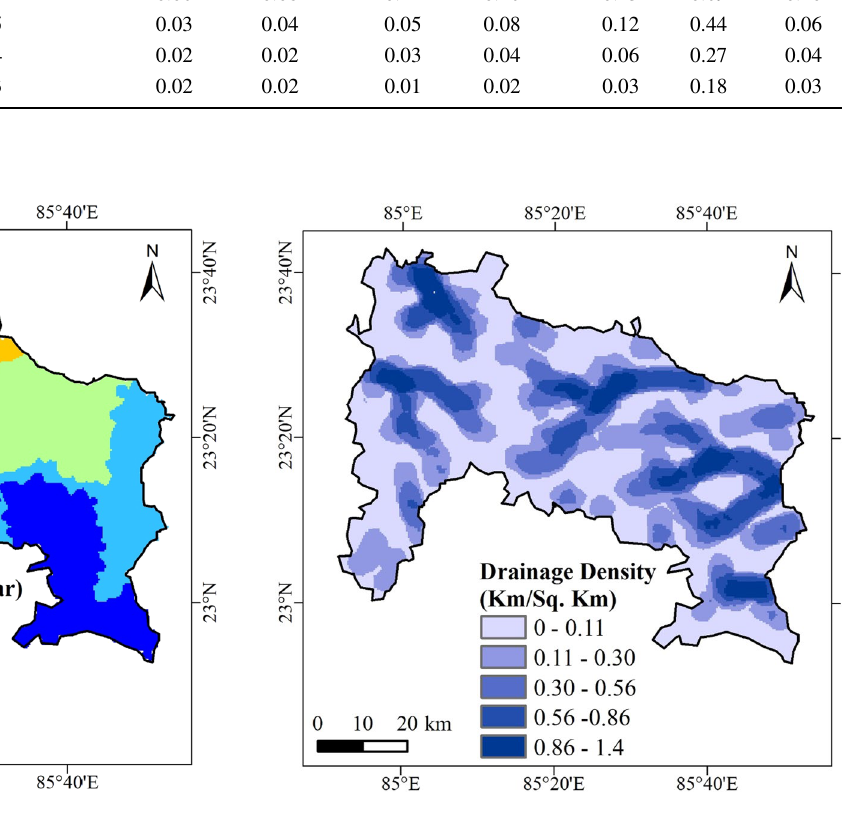
Fig. 3 Rainfall map Fig. 4 Drainage density